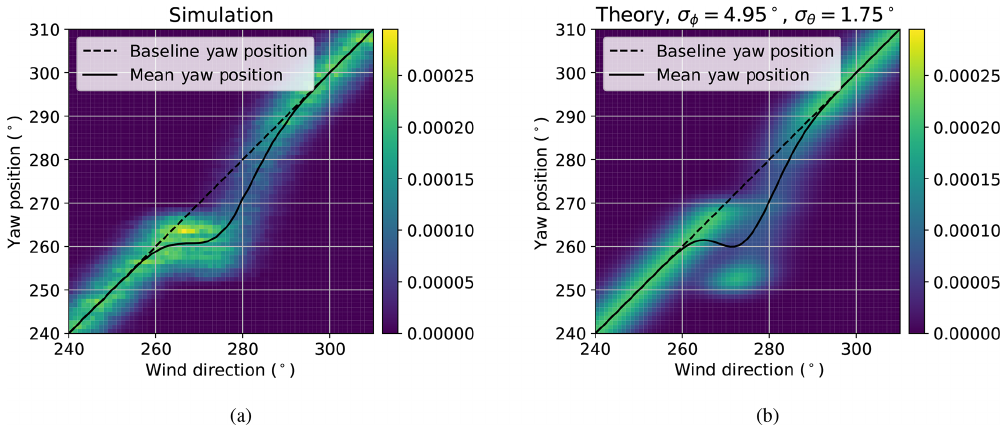
Figure 9. Distributions of low-frequency wind direction and yaw position with yaw offset control using a static-optimal yaw offset schedule: (a) histogram from simulation results and (b) theoretical probability density function assuming wind direction uncertainty with a standard deviation of 4.95 ◦ and yaw position uncertainty with a standard deviation of 1.75 ◦